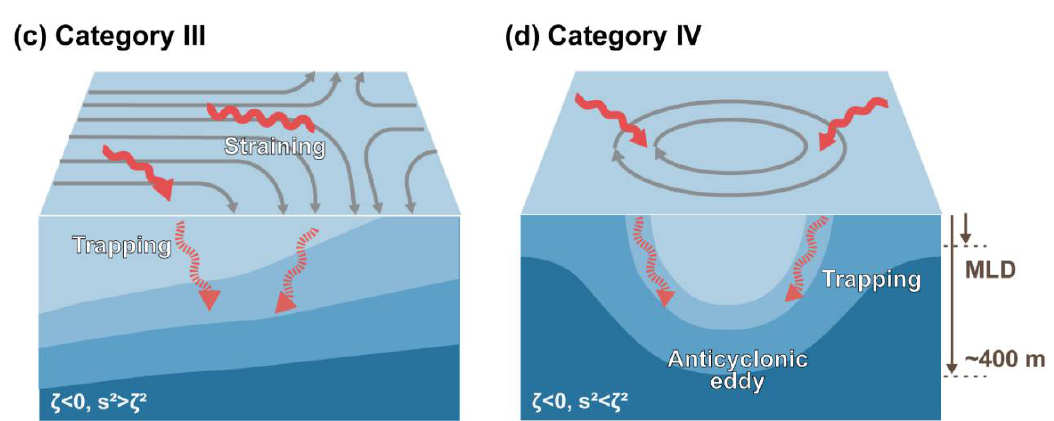
Figure 11. Schematics of behaviour of near-inertial internal waves (NIW, red arrow) under mesoscale flow fields (streamlines, grey arrows) yielding different conditions of ζ and α 2 ; ( a ) Category I ( ζ > 0 and S 2 > ζ 2 ), ( b ) Category II ( ζ > 0 and S 2 < ζ 2 ), ( c ) Category III ( ζ < 0 and S 2 > ζ 2 ), and ( d ) Category IV ( ζ < 0 and S 2 < ζ 2 ). Different blue shading colours represent different isopycnal layers. Vertical scales of MLD and 400 m reference level are shown with thick grey arrows in the right bottom of ( d ).